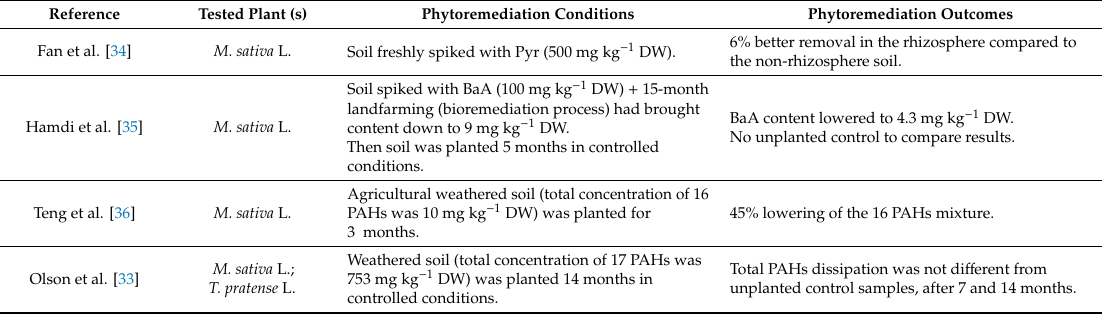
Table 5. Comparison of phytoremediation conditions and outcomes between a few published references for Medicago sativa L. and Trifolium pratense